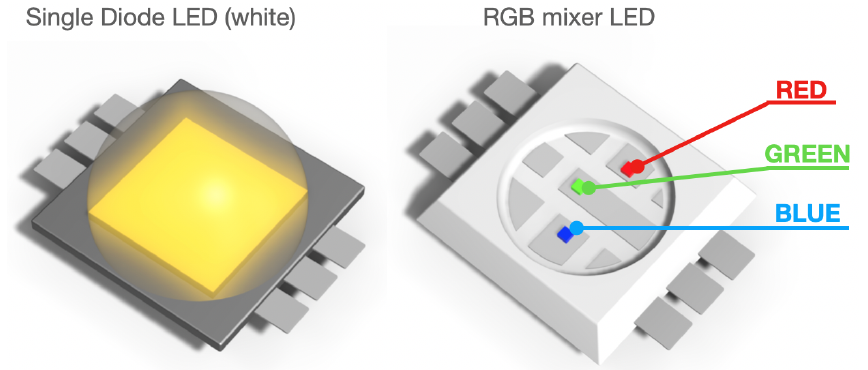
Figure 4. Single diode LED and RGB mixer LED. Illustration of the difference between the single- diode LED and RGB-mixer LED